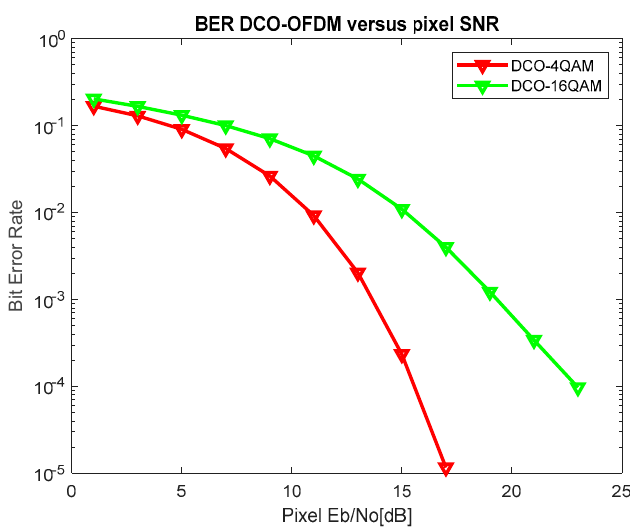
Figure 7. Simulation of BER DCO-OFDM versus pixel SNR.